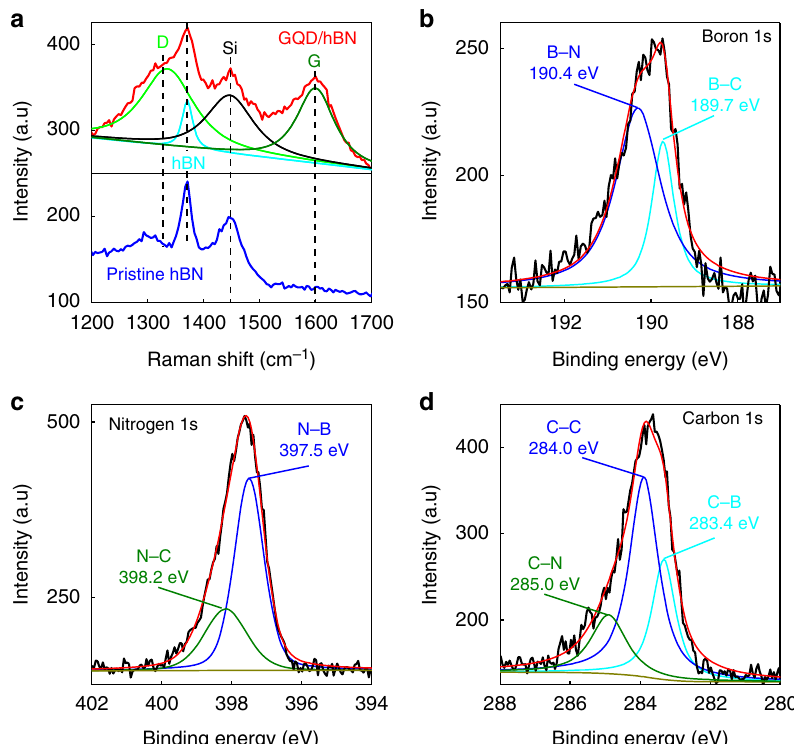
Fig. 3 Characterisation of GQD-hBN interface of the in-plane heterostructure with GQDs of the size of 7 nm. a Raman spectra of GQD-hBN planar heterostructure (red) and pristine hBN (blue). XPS spectra of GQD-hBN planar heterostructure: b boron 1s, c nitrogen 1s and d carbon 1s